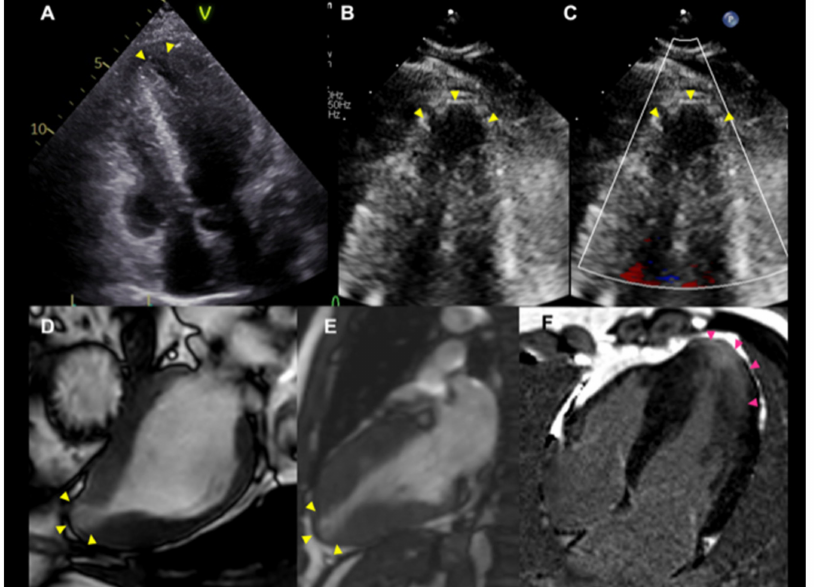
Figure 6. Representative cases with left ventricular apical aneurysm. Transthoracic echocardio- graphy ( A – C ) and cardiac magnetic resonance imaging ( D – F ). Yellow arrowheads indicate apical aneurysms and red arrowheads indicate late gadolinium